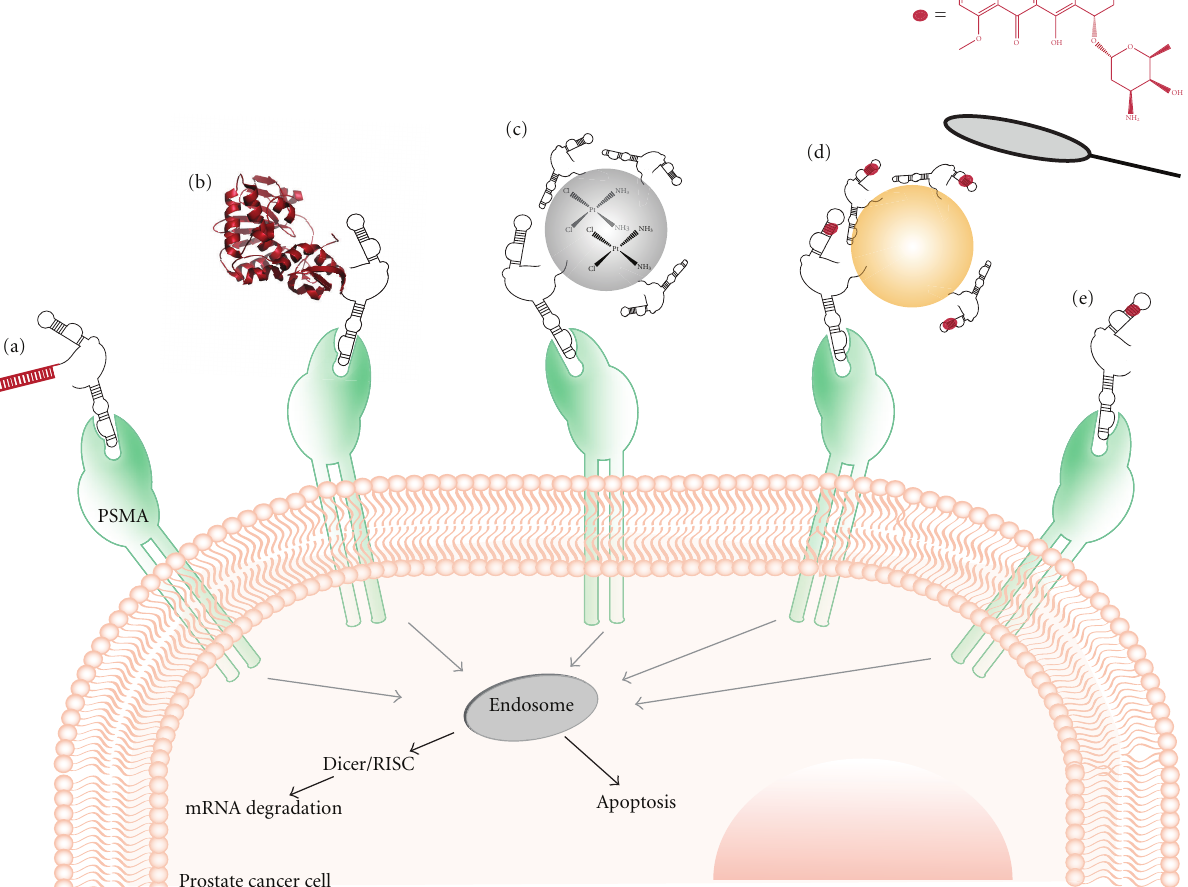
Figure 4: Aptamers as drug delivery agents. Prostate specific membrane antigen (PSMA) is internalized into cells via endocytosis. PSMA- binding RNA aptamers serve as drug delivery vehicles for small interfering RNAs (siRNAs, (a)). The siRNAs escape from the endosome, are processed by Dicer and RISC, and lead to the degradation of target mRNAs. Furthermore, the aptamers can escort cytotoxic molecules into prostate cancer cells like the ribosomal toxin gelonin (b), cisplatin encapsulated in organic PLGA-PEG-NPs (c), nanoparticles (NPs, gold, iron oxide and quantum dots; (d)), or doxorubicin as a physical conjugate (e). For references see